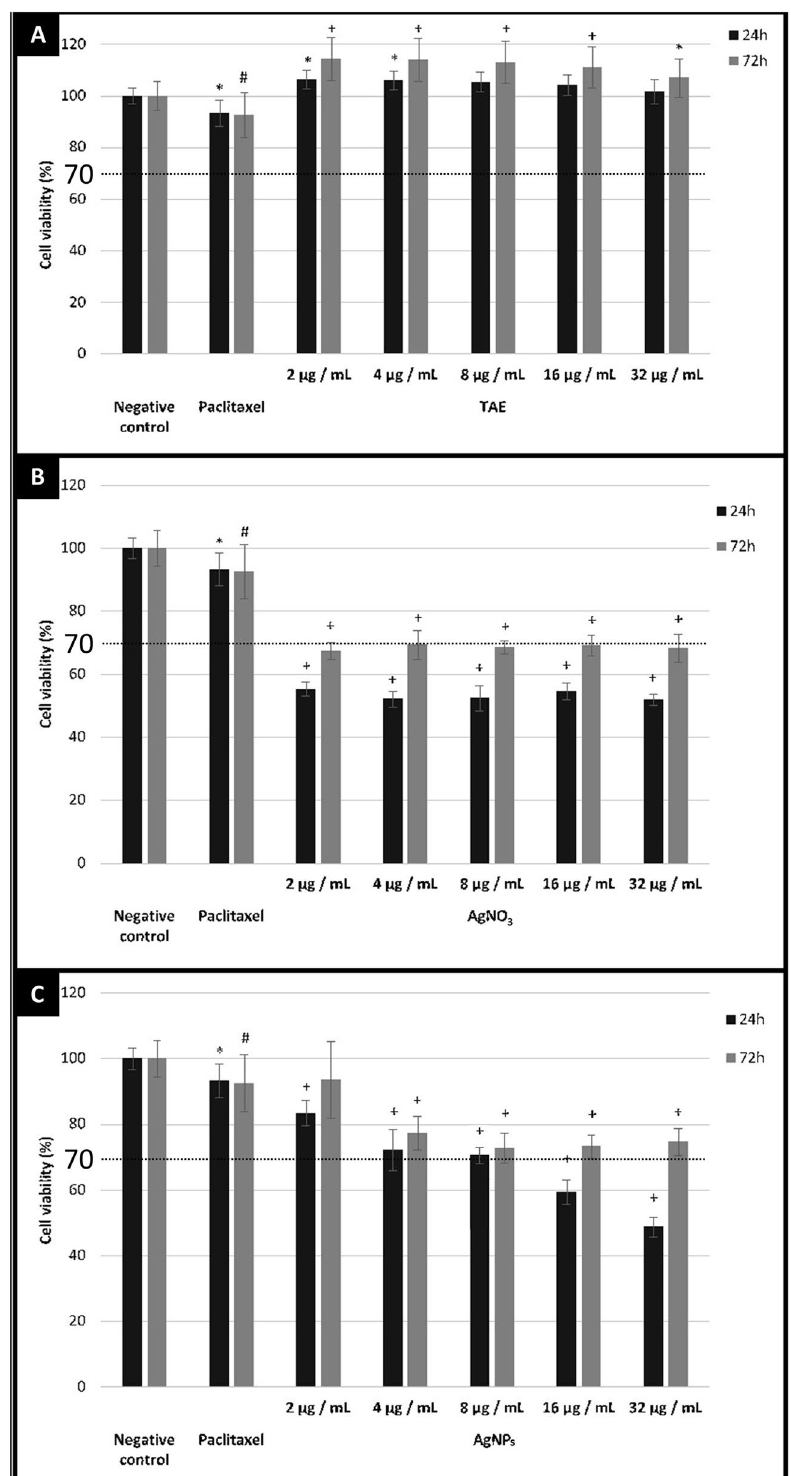
Figure 2. Percent cell viability after 24 and 72 h of incubation. Results are expressed as ( A ) µg LE/mL for TAE; ( B ) µg silver/mL for AgNPs; and ( C ) μg silver/mL AgNO 3 . Negative control: untreated cells. Positive control: paclitaxel (2.5 μg/mL). For each treatment and control group, the number of determinations was ≥ 12. The symbol *indicates a statistically significant difference from the negative control at P between 0.0137 and 0.0436; the symbol (#) indicates a statistically significant difference from the negative control at P between 0.0051 and 0.0067; the symbol (+) indicates a statistically significant difference from the negative control at P <